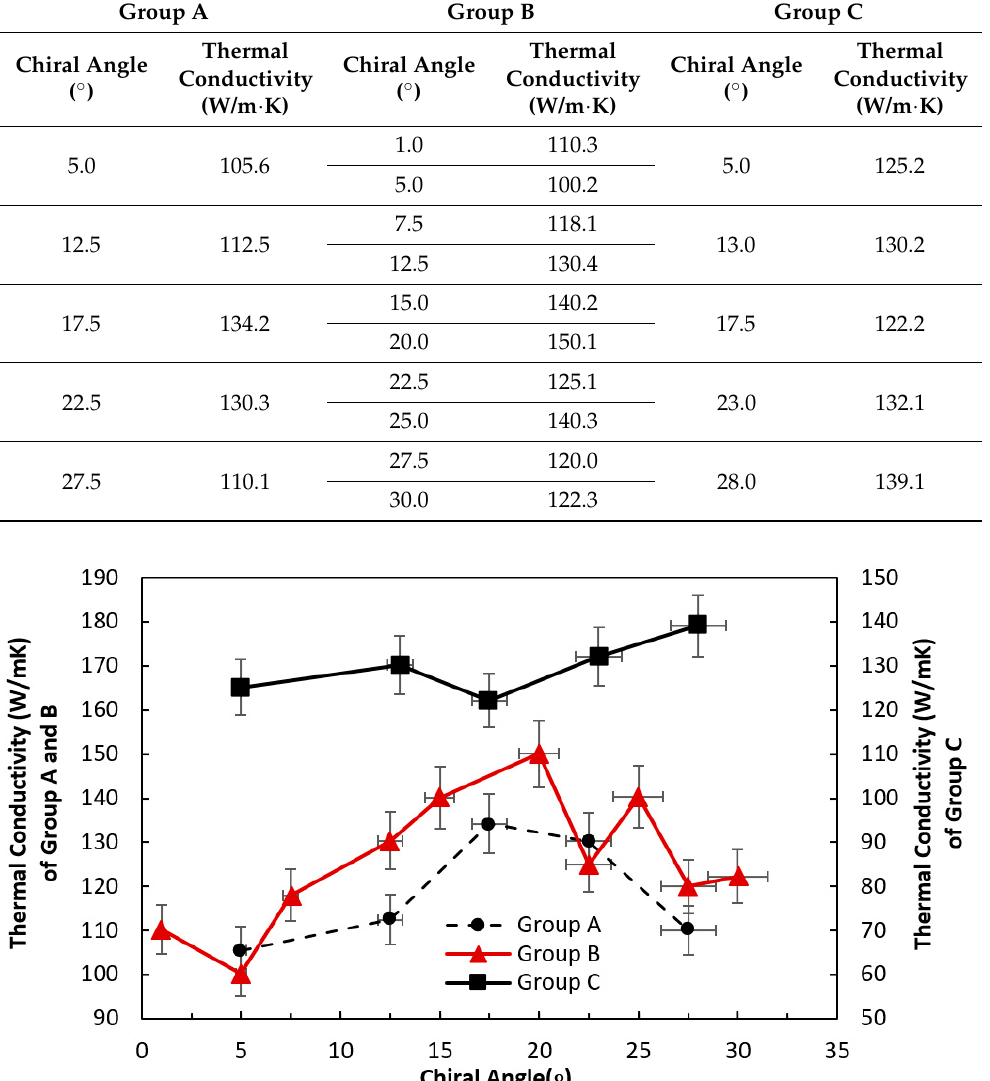
Figure 4. Chiral angle vs. thermal conductivity of smaller diameter shorter SWNTs with a tube length of 20 nm (Group A), larger diameter shorter SWNTs with a tube length of 20 nm (Group B), and smaller diameter longer SWNTs with a tube length of 50 nm (Group C). Table 1. Chiral angle-dependent thermal conductivities of group A, B and C of SWNTs [46,62–68].